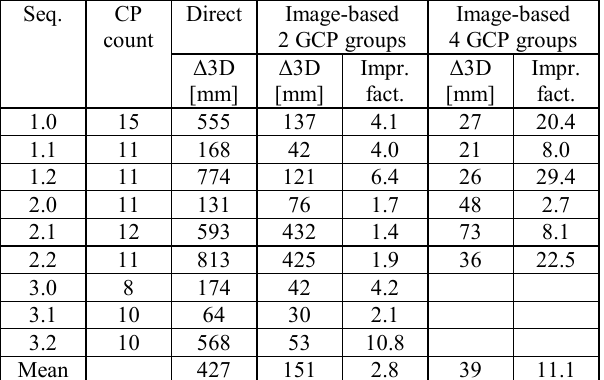
Table 6. RMSE values for check point residuals of direct and image-based georeferencing